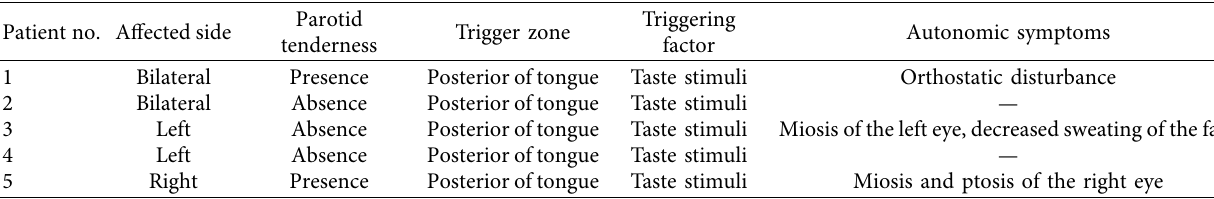
Table 2: Clinical findings in patients with idiopathic first bite